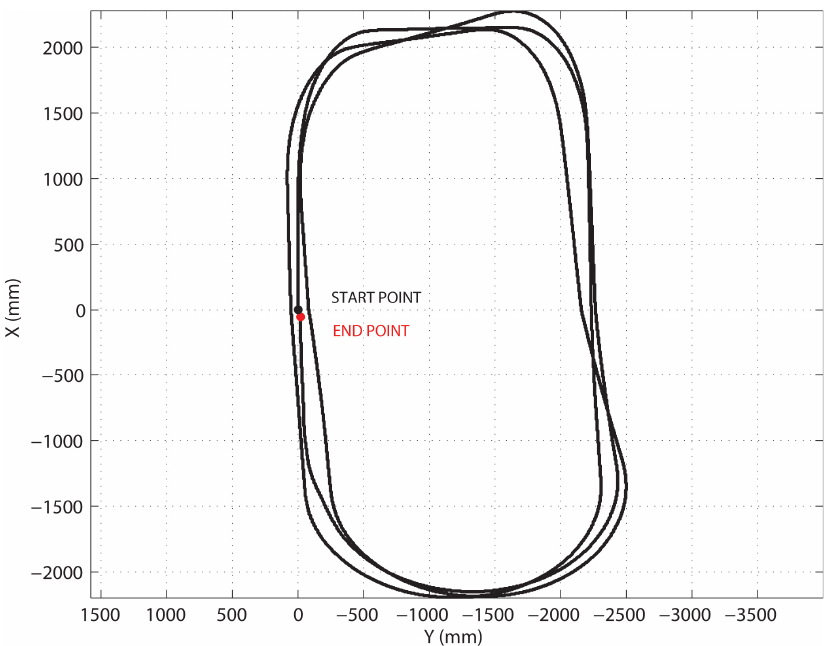
Figure 11. Path of the rover in a typical closed-loop run as derived by gyro-odometry, i.e. , linear and angular displacements were obtained by encoders and gyro, respectively.